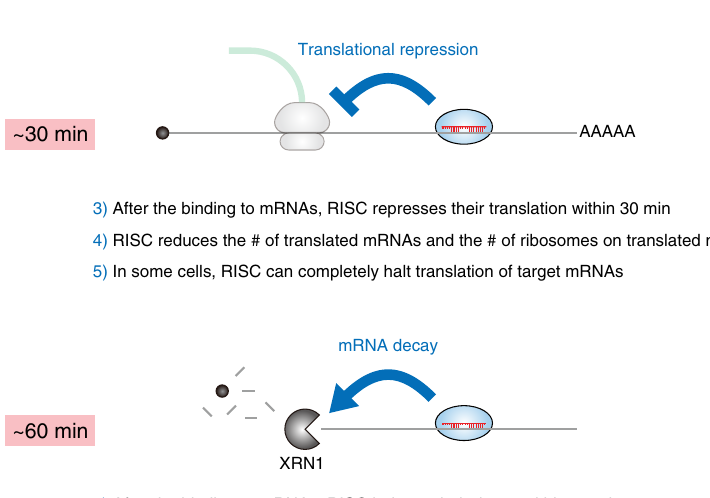
Fig. 7 A model of miRNA-mediated gene silencing; fi ndings from single-molecule imaging inside cells. After mRNAs are exported from the nucleus to the cytoplasm, RISC binds to them immediately. RISC preferentially binds to translated mRNAs rather than untranslated mRNAs. Then, RISC represses translation within 30 min after the binding to mRNAs. This action of RISC reduces the number of translated mRNAs inside cells, as well as the number of ribosomes on translated mRNAs. In some cells, RISC can completely halt translation of target mRNAs. Subsequently, RISC induces mRNA decay within 60 min after the binding to